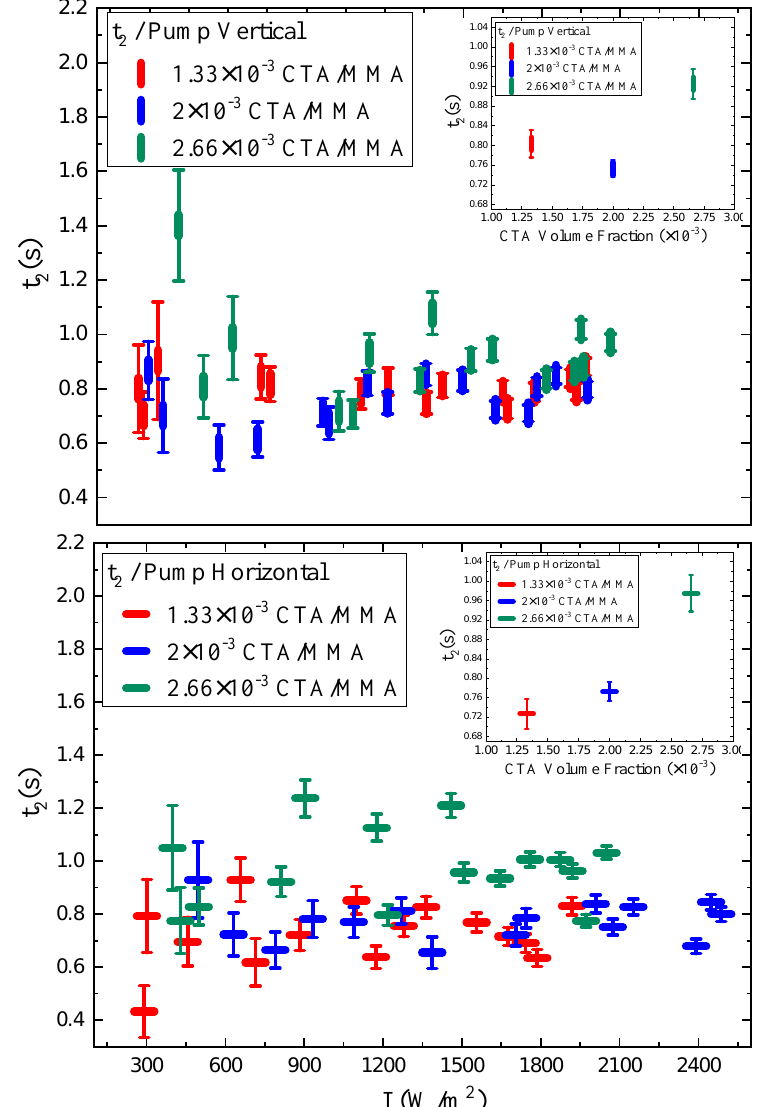
Figure 14. Time constant t 2 (light off) as a function of intensity for different CTA volume fractions for a vertically and horizontally polarized pump. The insets show the time constants as a function of CTA volume fraction averaged over all